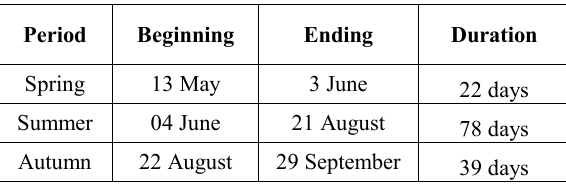
Table 1. The averaged frames of the growing seasons during 2000-2013